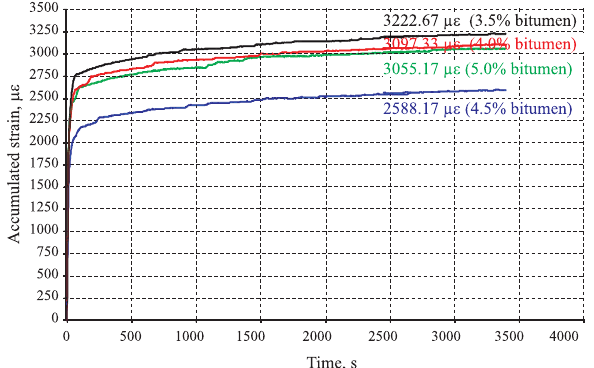
Fig. 8. Average accumulated strain versus time graphs for optimum-optimal polypropylene modified specimens (according to air